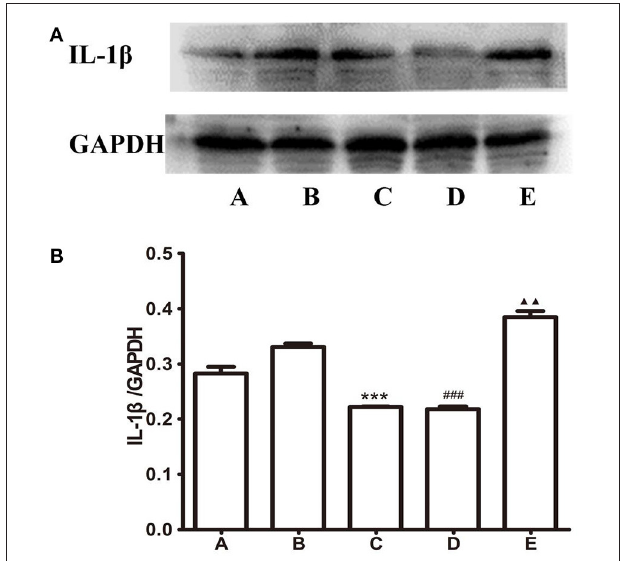
FIGURE 11 | Expression of CGRP in the gastric mucosa. Western blots of CGRP and GAPDH in gastric mucosa. Quantitative analysis of CGRP expression in the gastric mucosa. GAPDH was used as a loading control. * P < 0.001, as compared with the GI-R group. A, Normal group; B, GI-R